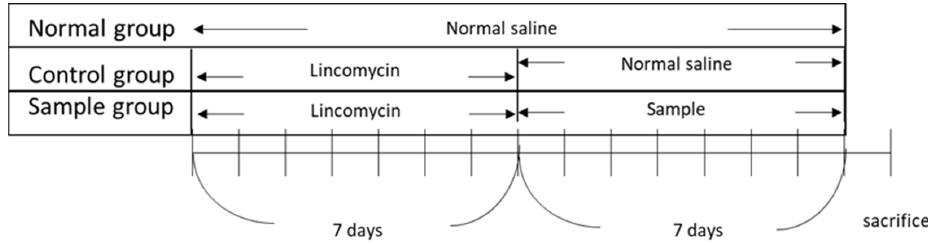
Figure 1. Schematic of the in vivo experiment to induce an antibiotic-associated diarrhea model in BALB/c mice.